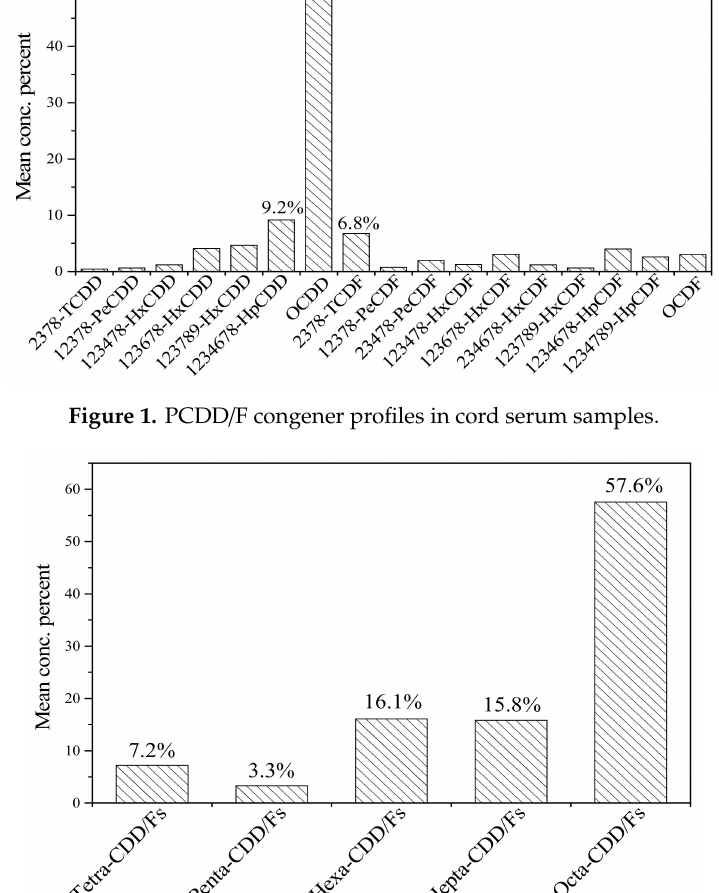
Figure 2. Comparison of di ff erent PCDD / F congener groups in cord serum